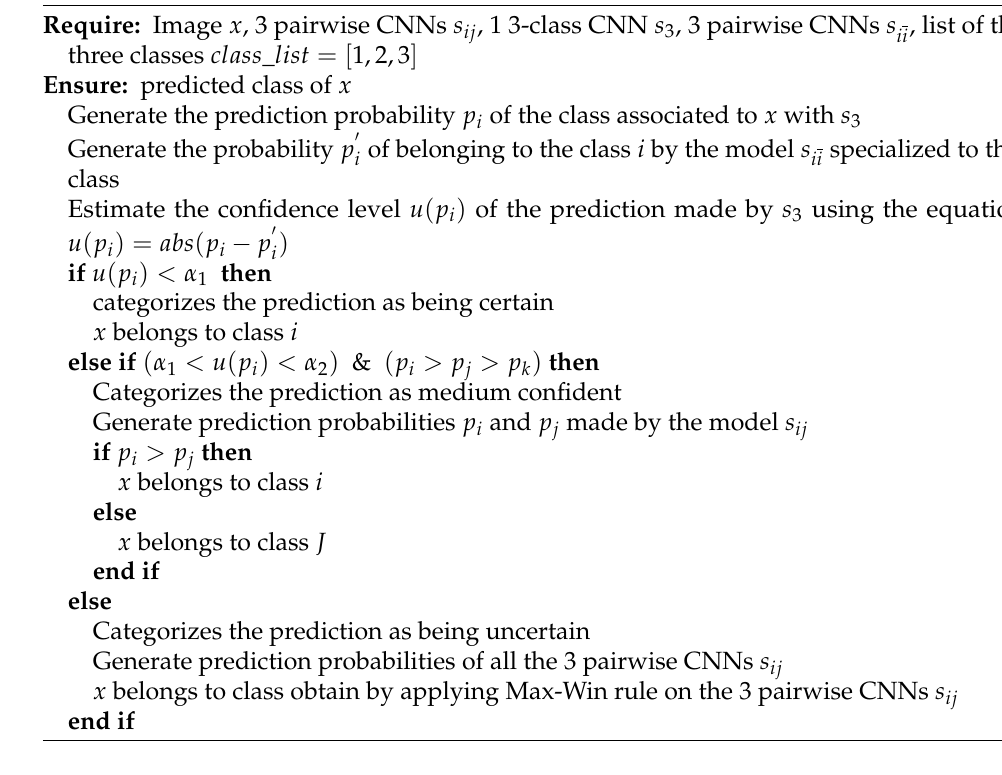
Algorithm 1 Pseudo-code of our